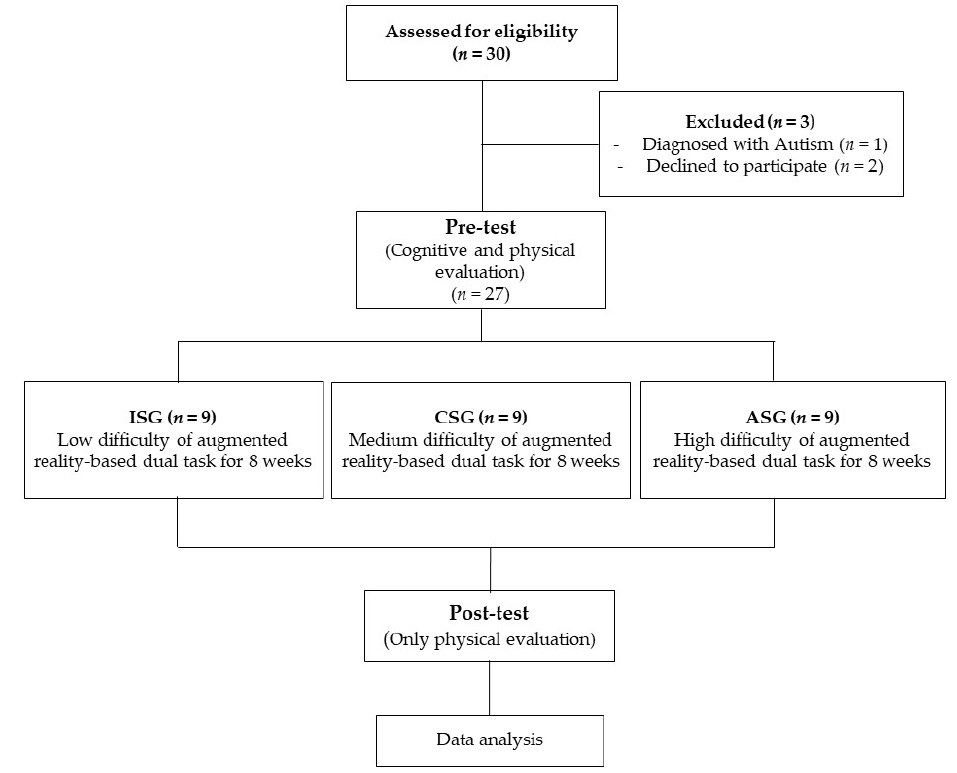
Figure 1. Experimental procedure.